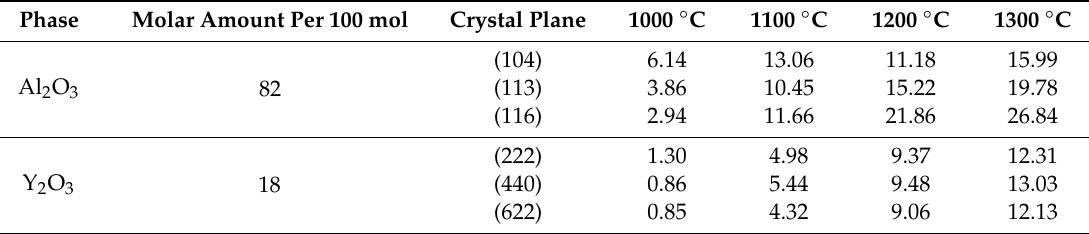
Table 2. Rough quantitative comparison of crushing amount of di ff erent crystal planes of α -Al 2 O 3